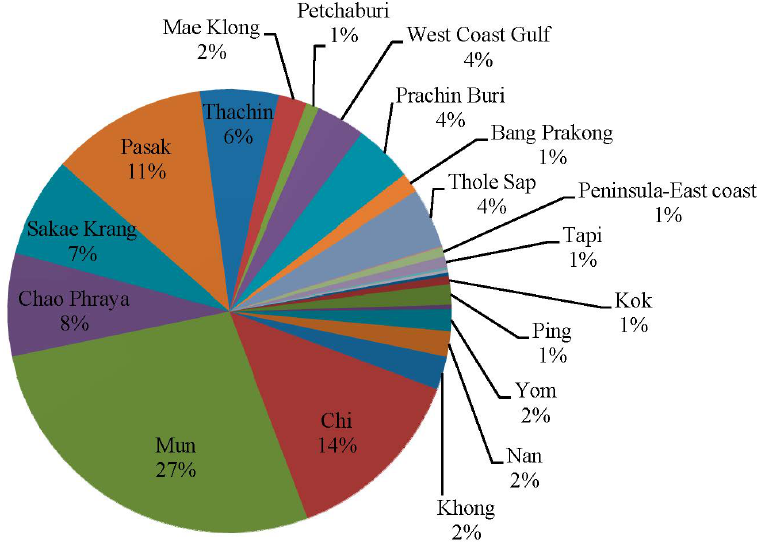
Figure 6. Share of water deprivation from staple crops production in 2011 classified by